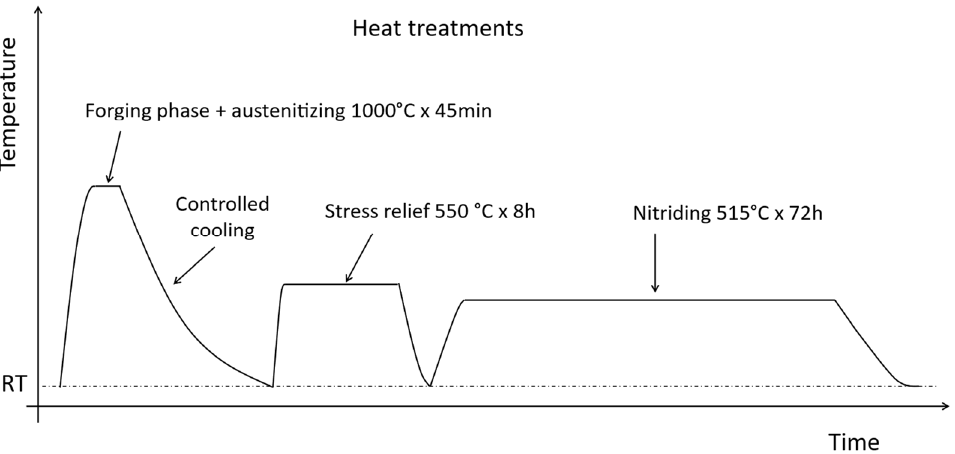
Figure 1. Scheme of the heat treatment cycle performed on the specimens (RT—Room Temperature, 20 °C).